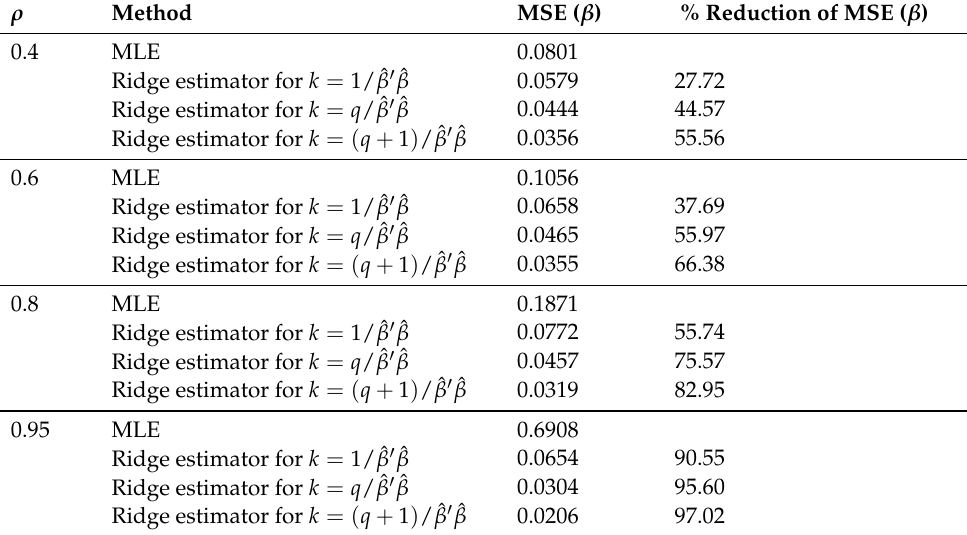
Table 1. Comparison of MSE between the MLE and ridge estimators in simulation; n =